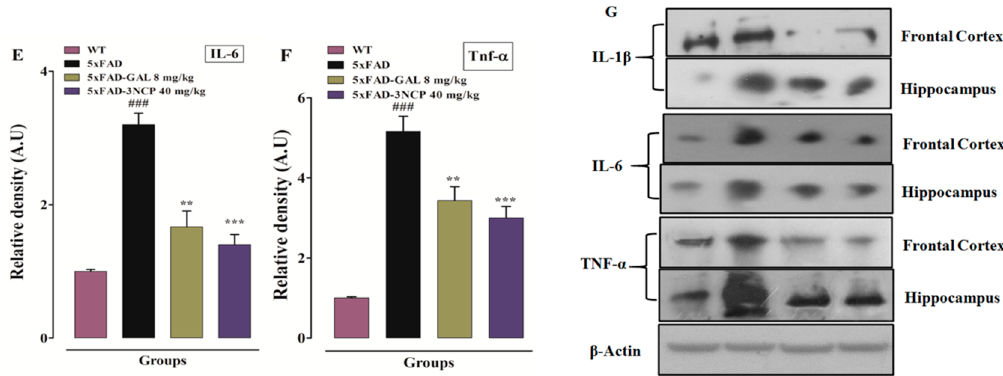
Figure 8. The relative density of IL- β 1 ( A ), IL-6 ( B ), TNF- α ( C ) in FC and relative density of IL- β 1 ( D ), IL-6 ( E ), and TNF- α ( F ) in HC of 5xFAD mice following treatment with 3NCP. Immunoblot of IL- β 1, IL-6, and TNF- α ( G ). β -Actin was used as the loading control. The results were determined using ImageJ software and expressed in arbitrary unit (A.U). Bars indicate mean in A.U ± SEM. ** p < 0.01, *** p < 0.001 compared to 5xFAD-mice and ### p < 0.001 compared to WT-mice ( n = 4).